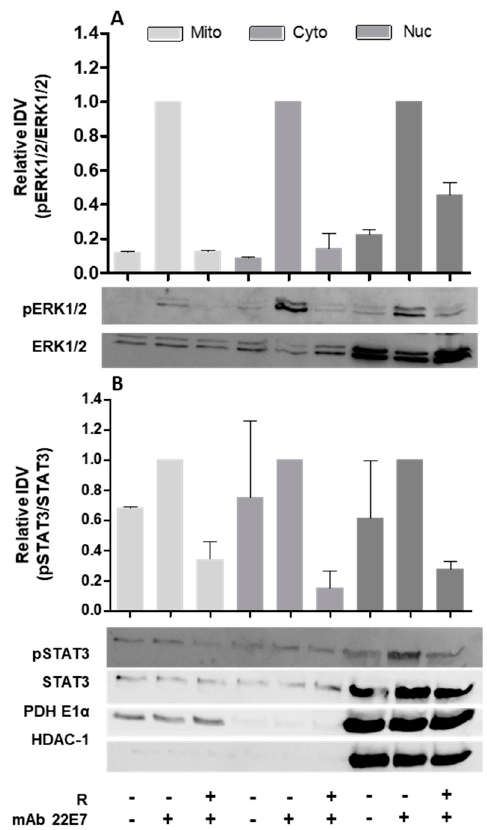
Figure 4. Phosphorylation of STAT3 and ERK1/2 in nuclear and mitochondrial fractions of hiMC following treatment with resveratrol. Western blot analyses of two independent experiments of ( A ) phosphorylated ERK1/2 and ( B ) phosphorylated STAT3 after subcellular fractionation in pure mitochondria (Mito), cytosol fraction (Cyto), and crude nuclear fraction (Nuc), respectively. HiMCs were treated with 50 μ M of resveratrol (R), or corresponding concentrations of the vehicle DMSO (control), and stimulated by Fc ε RI crosslinking with 100 ng/mL of mAb 22E7 for 5 min. Exemplary pictures and densitometric analyses in relation to stimulated control for Western blots of phosphorylated ERK1/2 and total ERK1/2, and phosphorylated STAT3 and total STAT3, are shown. Values are mean ± SEM ( n = 2).